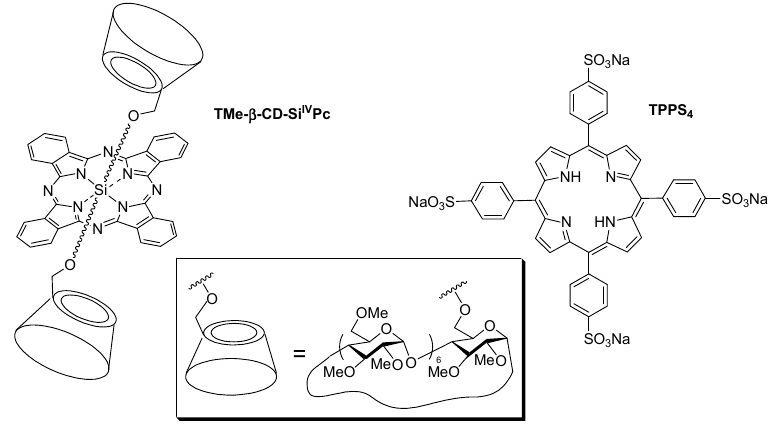
Figure 6. Schematic representation of TMe- β -CD-Si IV Pc and TPPS 4 . Adapted from Leng; Choi; Lo; Ng [122].